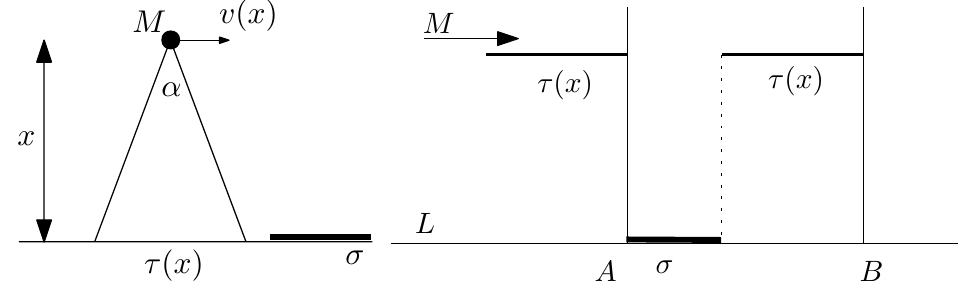
Figure 3. Drone M is flying over a line segment L of length (cid:96) and a certain object of length σ . At height x , the drone flies with speed v ( x ) which depends on the altitude x . The picture in the righthand side indicates that the drone’s camera has a sliding window effect of width τ ( x ) within which it can detect an object of length σ